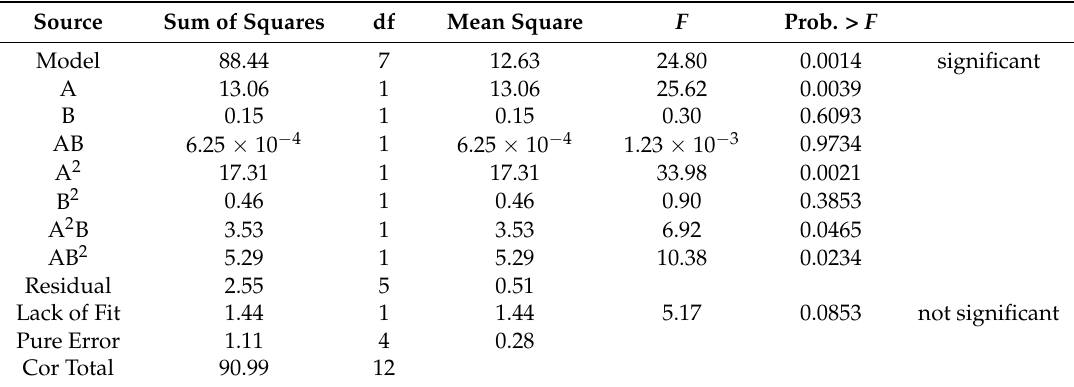
Table 3. Analyses of variance (ANOVA) for response surface model for tensile strength of POM composites using